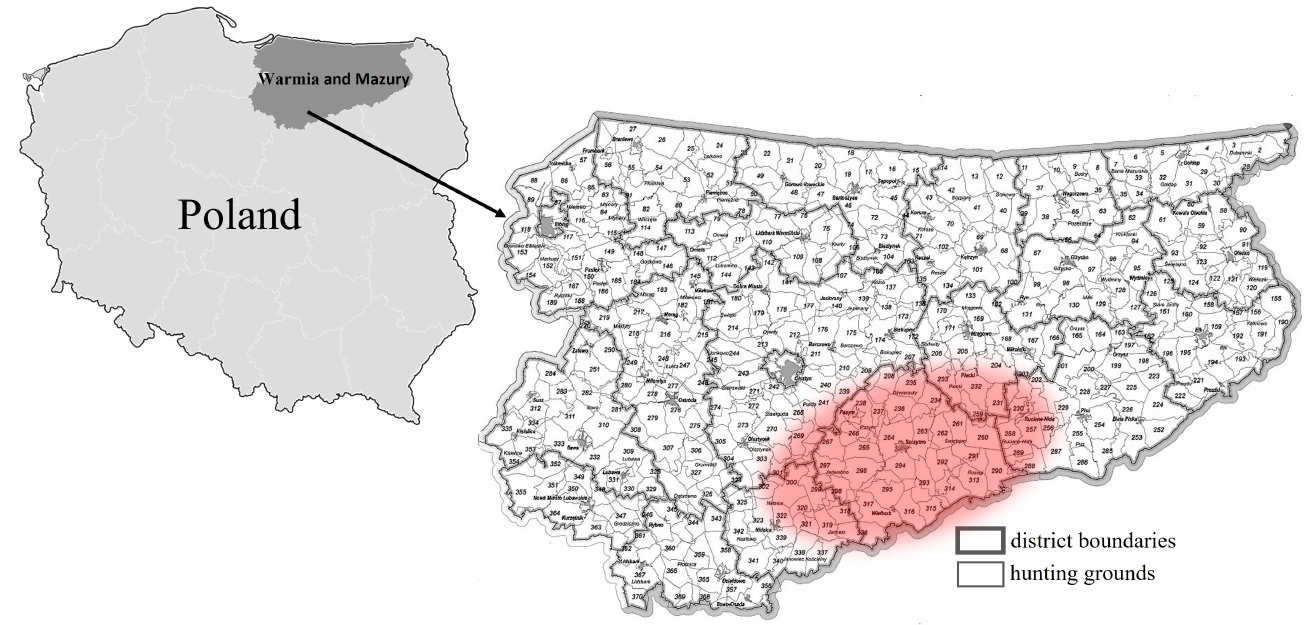
Figure 1. The area covered by the diagnostic survey (red